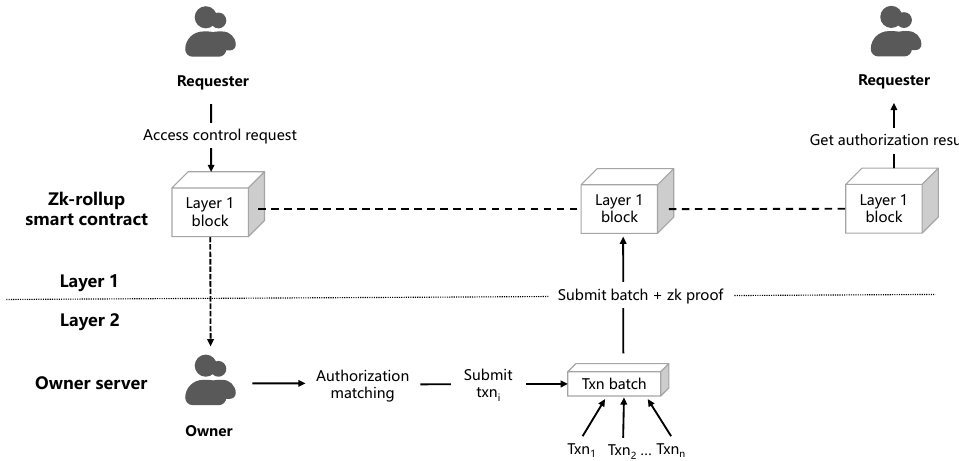
Figure 4. Procedure of the ZK-rollup in the proposed